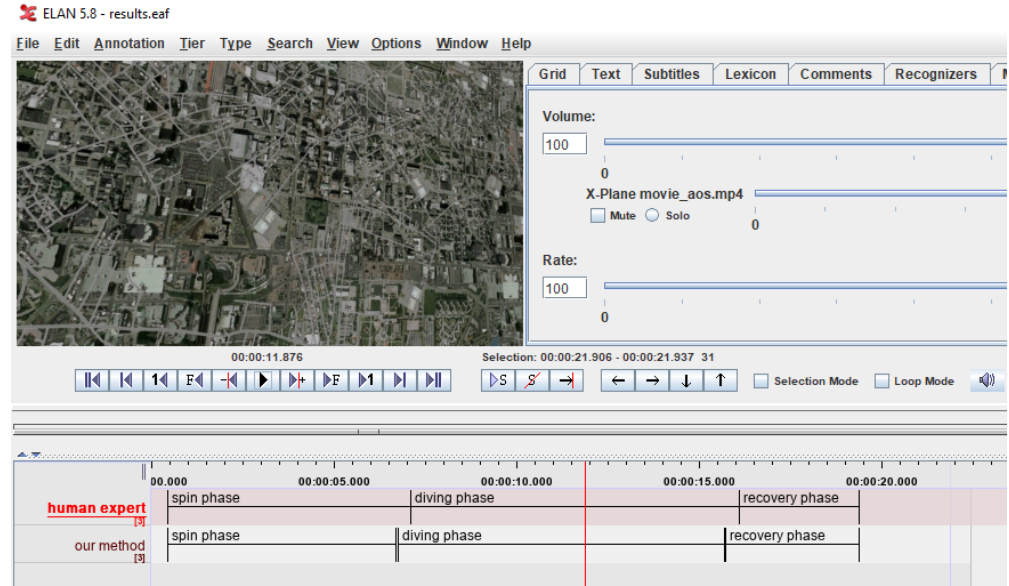
Figure 13. Qualitative evaluation of results in ELAN after automatic insertion of “our method”